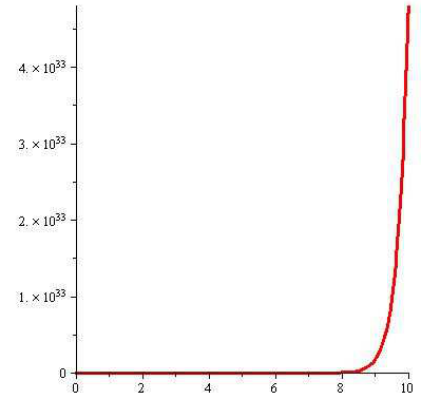
Figure 7: Graph of PM 2 ( OX n )